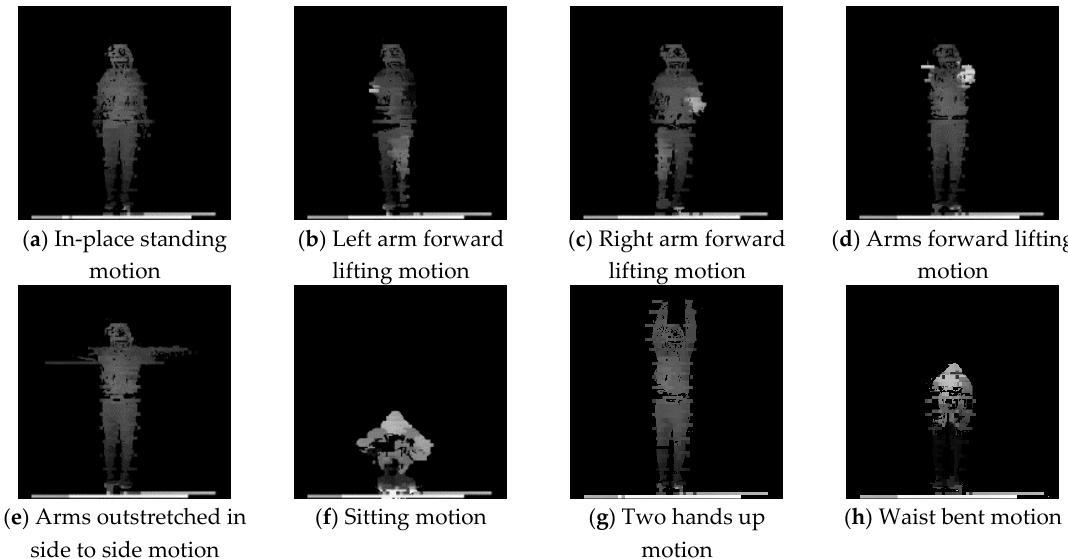
Figure 10. Depth images generated by the proposed method.